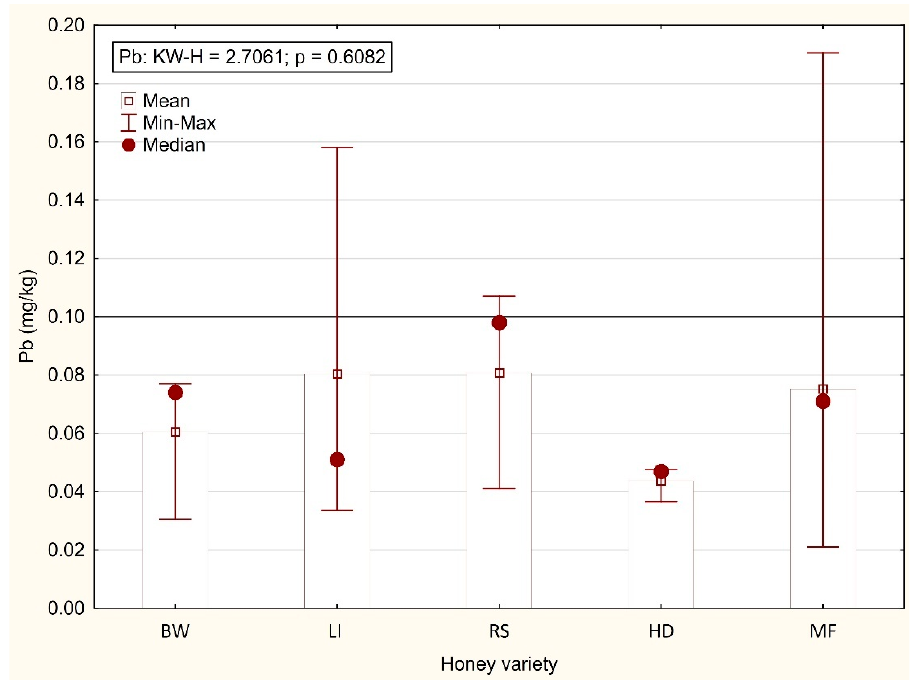
Figure 1. Content of Pb (mg/kg) in varietal honeys (BW—buckwheat; LI—linden; RS—rapeseed; HD—honeydew; MF—multifloral).